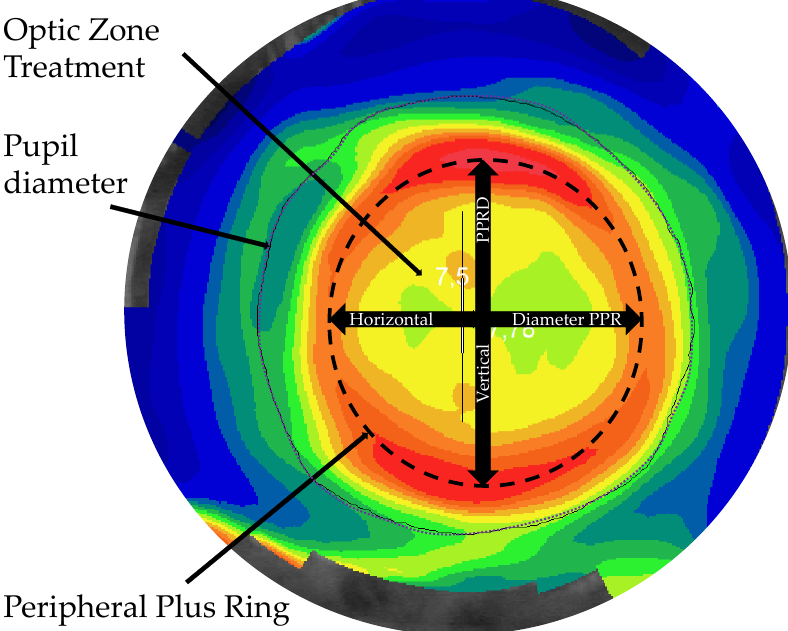
Figure 1. A tangential topographic map shows the plus power ring (PPR) diameter analyzed in this